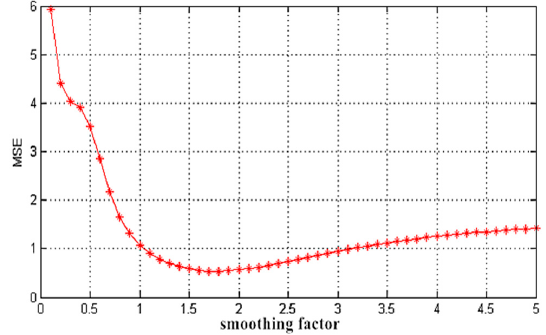
Figure 4. Parameter optimization of the smoothing